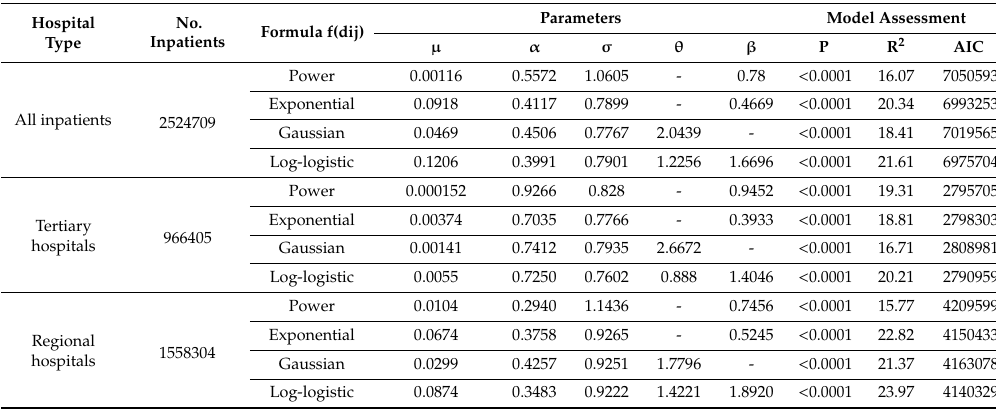
Table 2. Simulation results of the distribution of patients at di ff erent medical institutions of di ff erent levels and specialties in